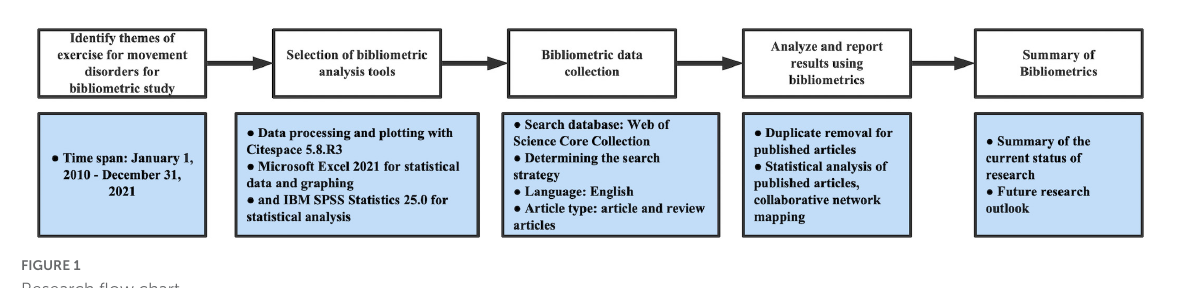
FIGURE1 Research flow